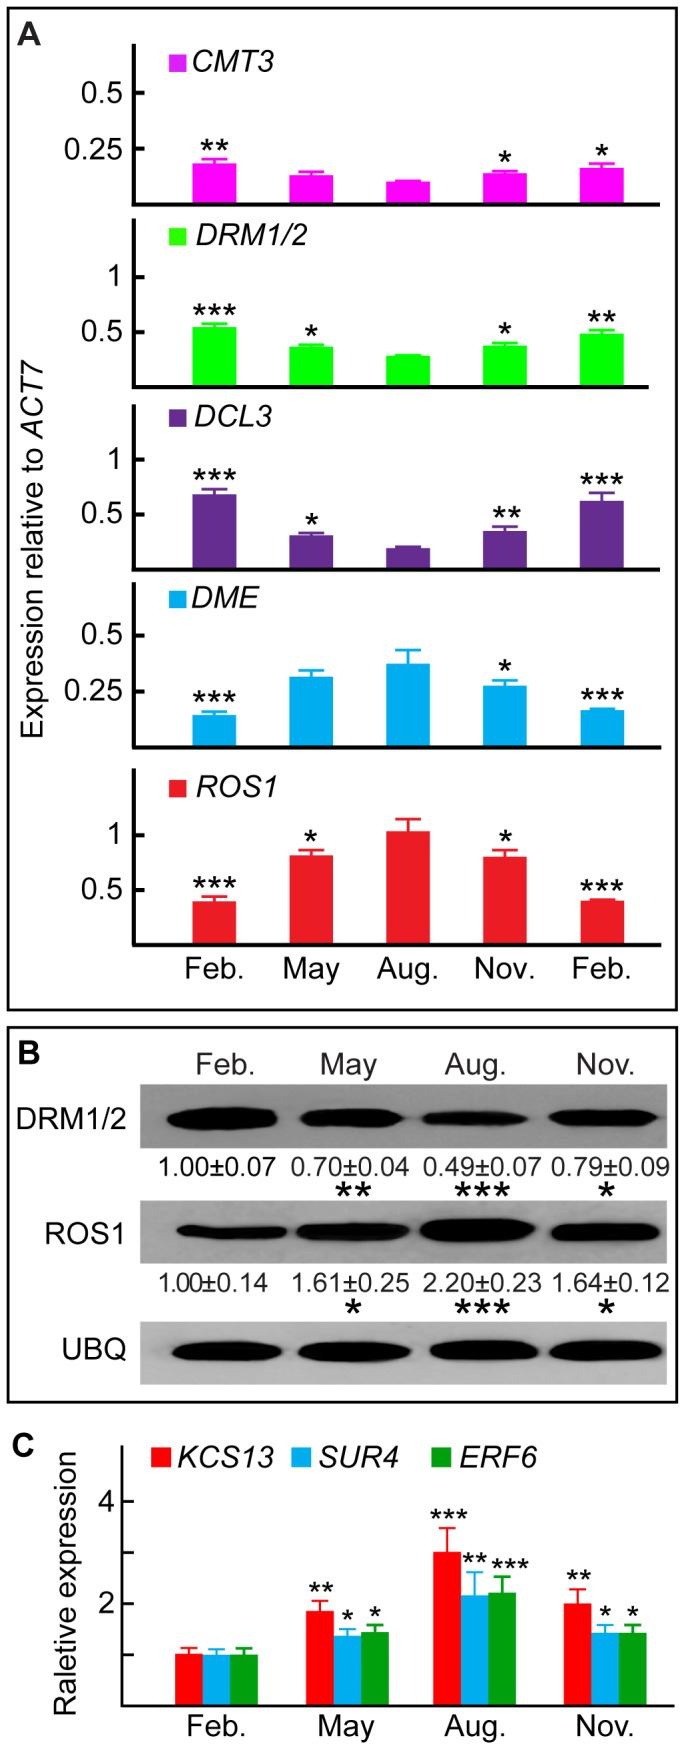
Annual changes in DNA methylation patterns in cotton ovules.(A) qRT-PCR analysis of DNA methylation and demethylation genes reported in GO: 0006306. The ACT7 transcript, normalized against that of all 20 housekeeping genes reported in Table S5, was used as the internal standard. (B) Western blot analysis of DRM1/2 and ROS1. May, August, and November signal intensities were normalized to those from February (arbitrarily set to 1). Values (mean ± SE from three independent experiments) are shown beneath representative bands. Cotton UBQ was used as a loading control. (C) KCS13, SUR4 and ERF6 transcript levels changed over the course of the year, as quantified by qRT-PCR. May, August, and November values were normalized to February values (arbitrarily set to 1).